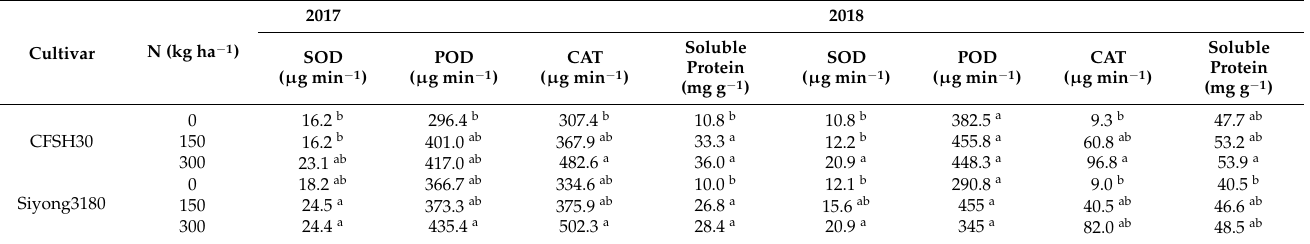
Table 5. Effects of N rates on super oxide dismutase (SOD), catalase (CAT), peroxidase (POD), and total soluble protein of two sorghum varieties, during 2017 and 2018.